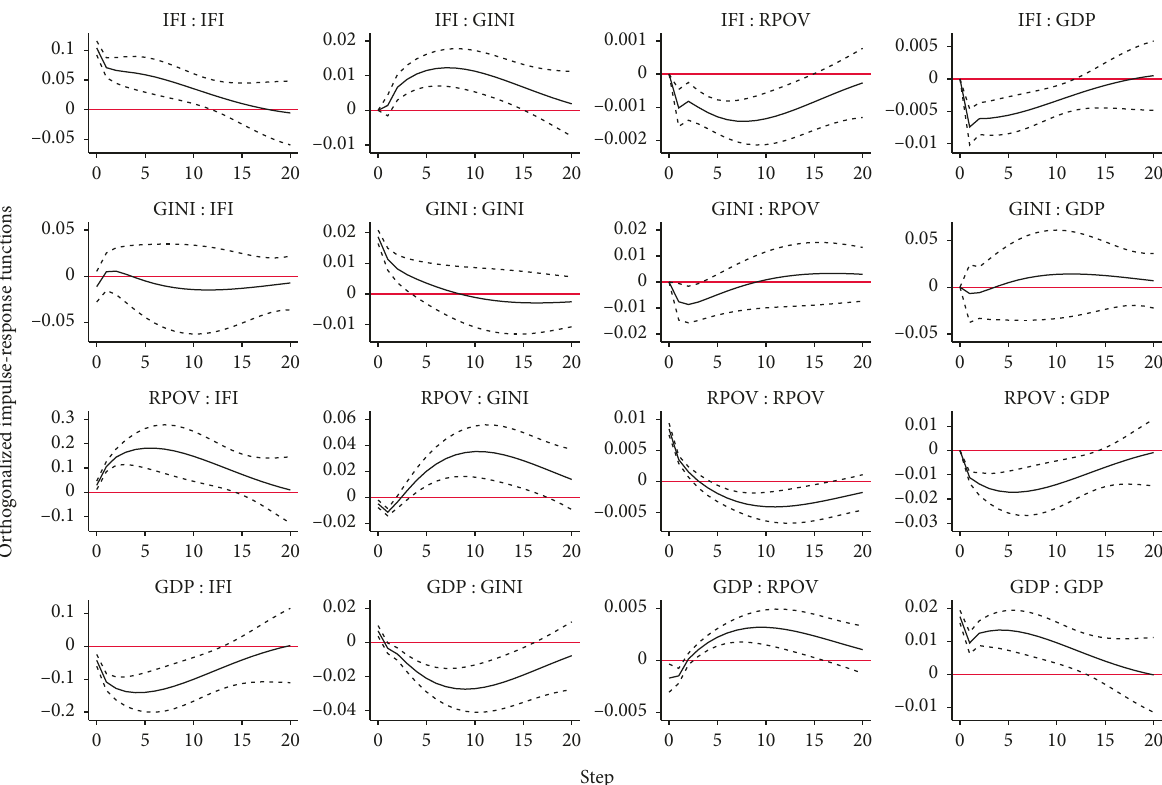
Figure 3: Impulse response function in the eastern